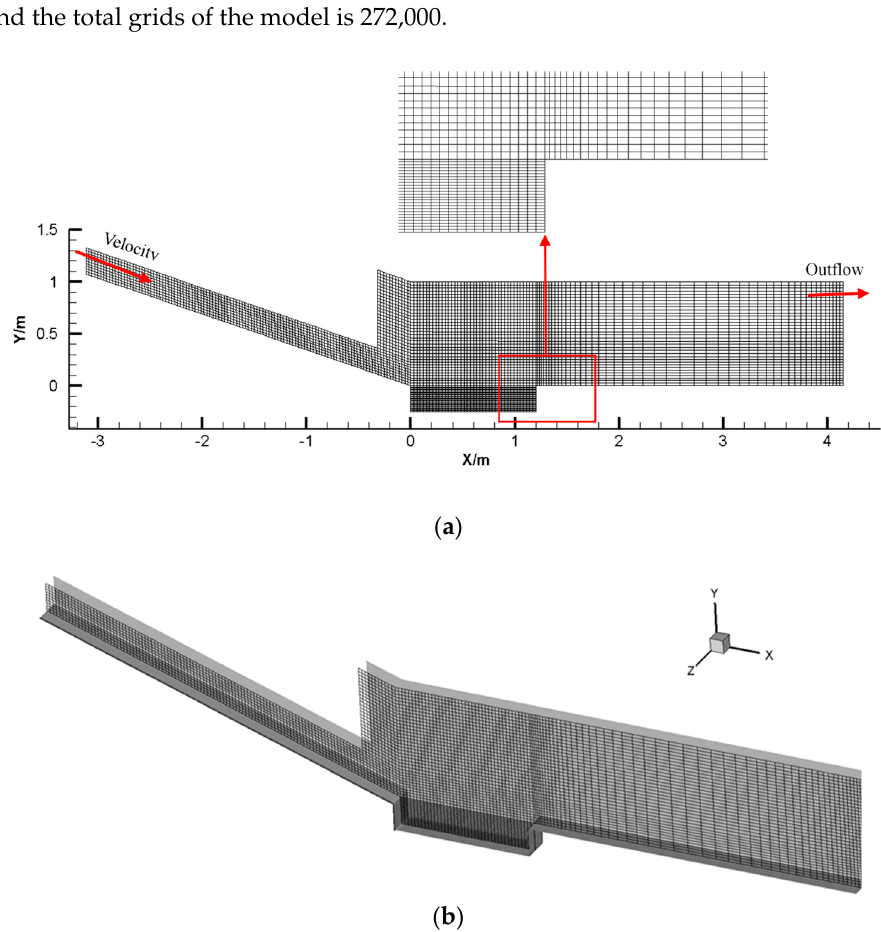
Figure 2. Schematic diagram for computational domain and grids of mathematical model. ( a ) Axial cross-sectional view; ( b ) The entire calculation domain.